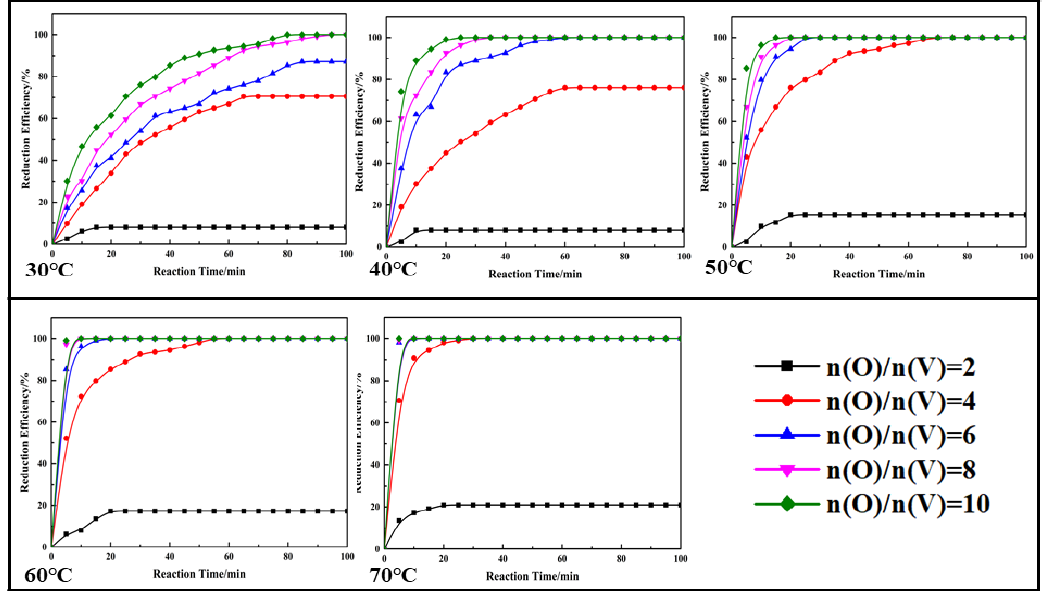
Figure 2. Effect of dosage of oxalic acid on the reduction efficiency of vanadium.